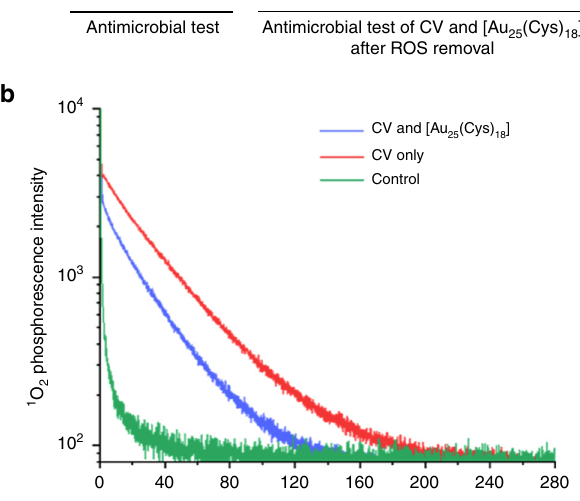
death 26 . The polymer containing CV only did not show any photobactericidal activity herein, upon exposure to low intensity white light. However, the addition of [Au 25 (Cys) 18 ] to CV resulted in potent photobactericidal activity under identical conditions.